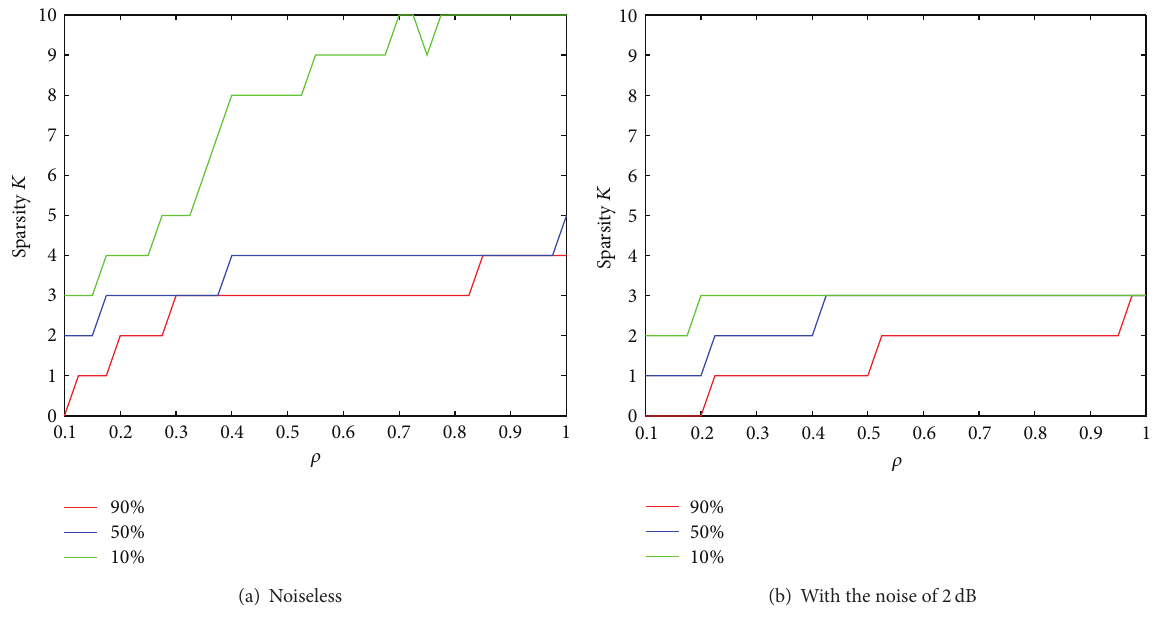
Figure 7: Phase transitions